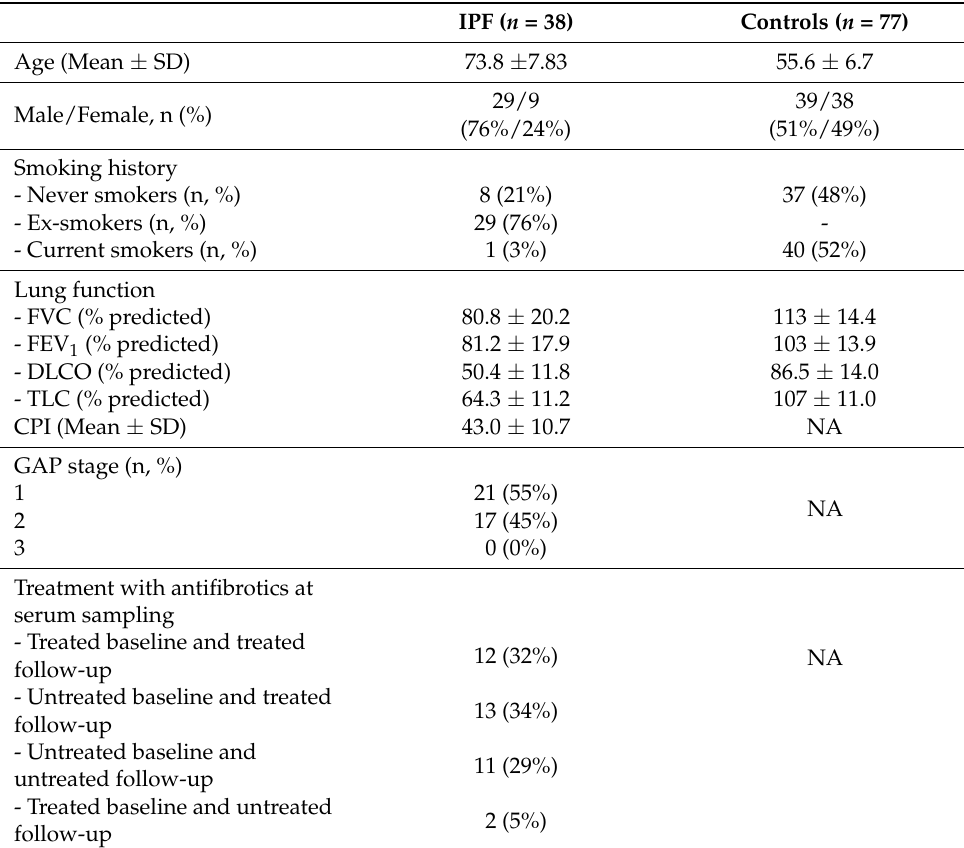
Table 2. Characteristics of IPF patients and